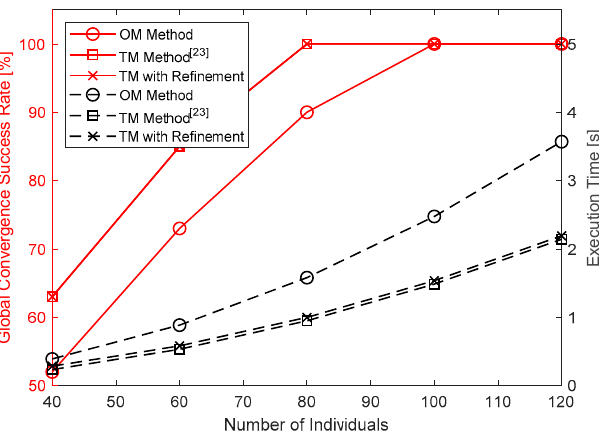
Figure 8. Comparison of the global convergence success rates and executed times as a function of the number of individuals used in the participatory searching algorithm (PSA).